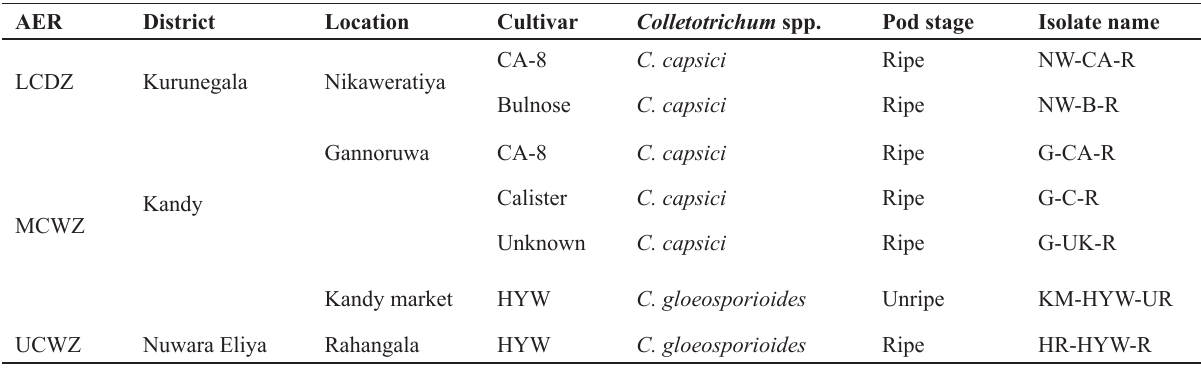
Table 2: Sources of seven isolates of Colletotrichum spp. obtained from infected fruits. AER District